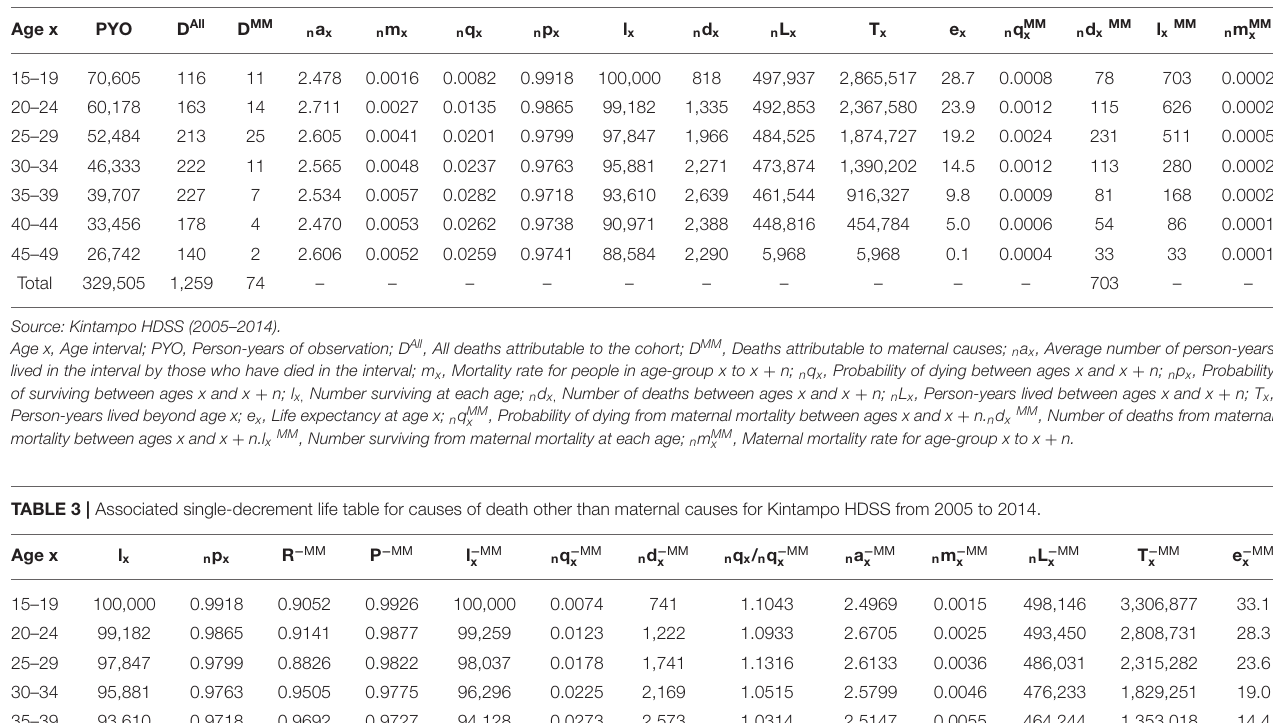
TABLE 2 | A multiple-decrement life table for WRA, Kintampo HDSS (2005–2014).